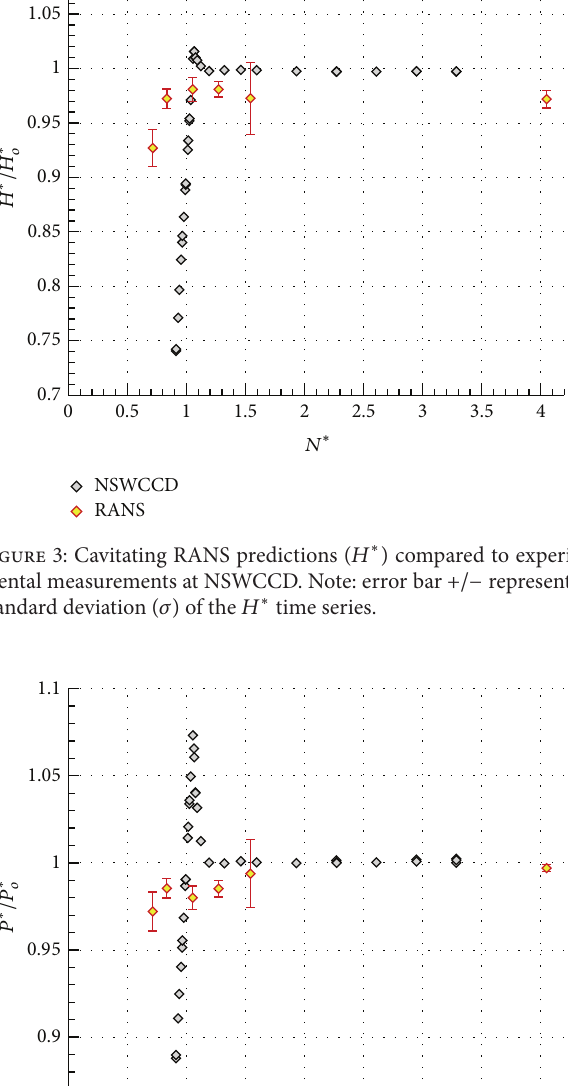
Table 1: Full-scale and model-scale vessel characteristics of ONR T-Craft.